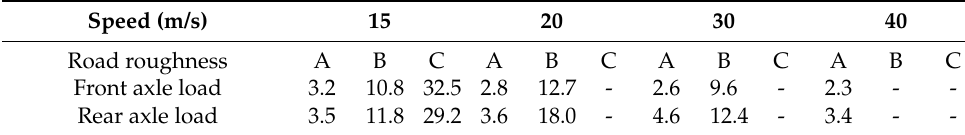
Table 8. The relative error (%) of the identified forces at 2% noise.